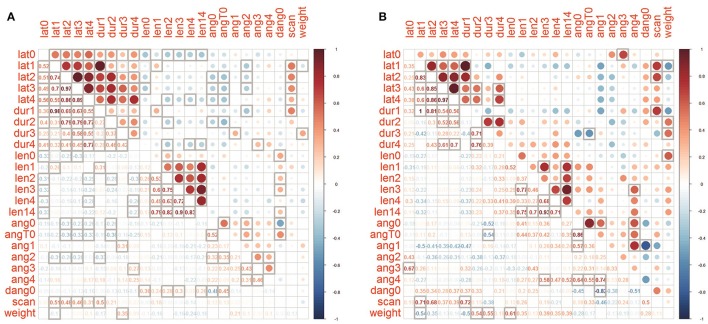
Correlation matrices of parameters for (A) joined controls and (B) PF group. Cells with bold borders are significant (p < 0.05), below main diagonal the Spearman's rho values are shown.